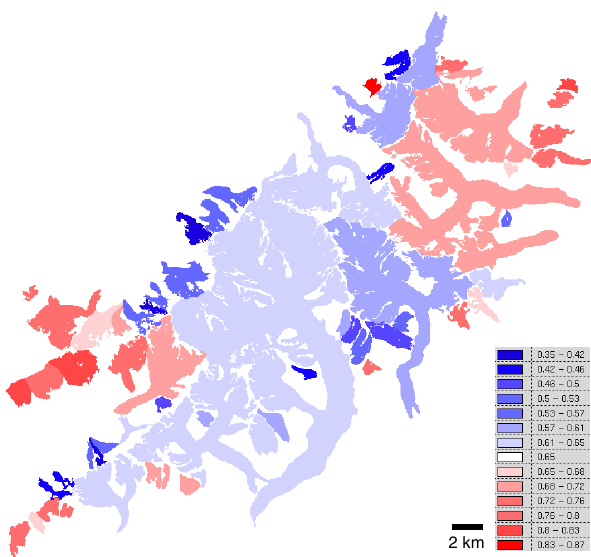
Fig. 6. Mass balance sensitivity for a one degree temperature in- crease based on the DEM and outlines from 1850 (difference